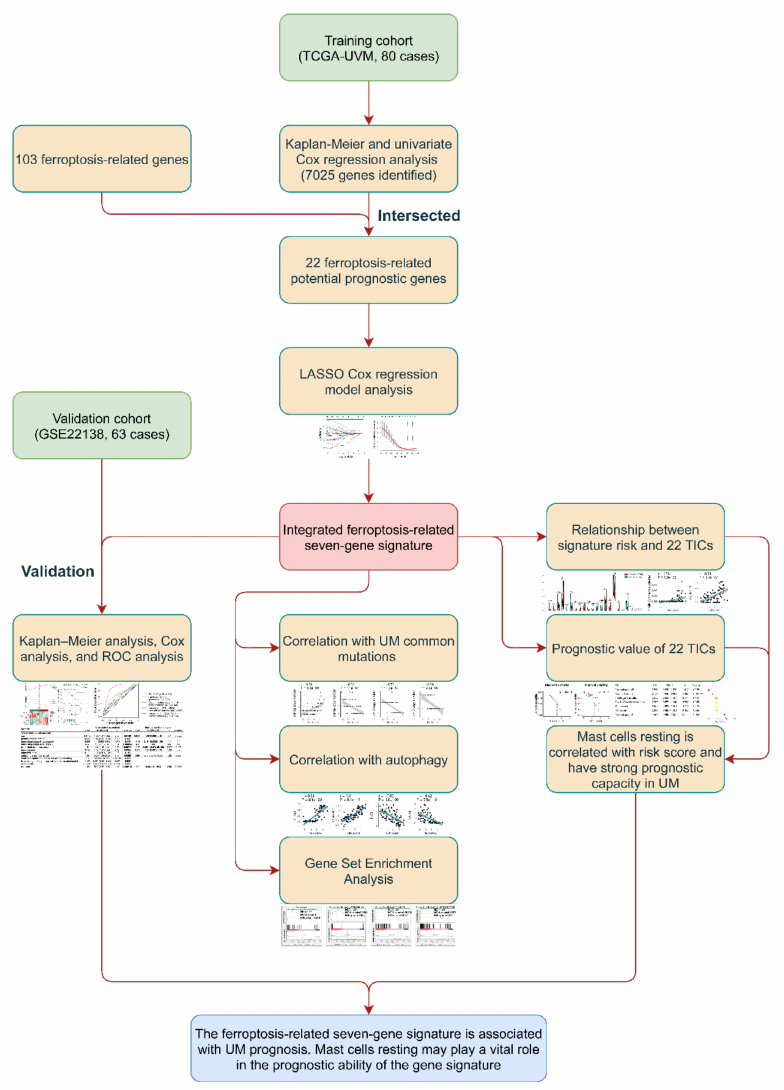
Figure 1. Flow chart of the study. LASSO: the least absolute shrinkage and selection operator Cox regression model; UM: uveal melanoma; ROC: receiver operating characteristic; TICs: tumor- infiltrating immune